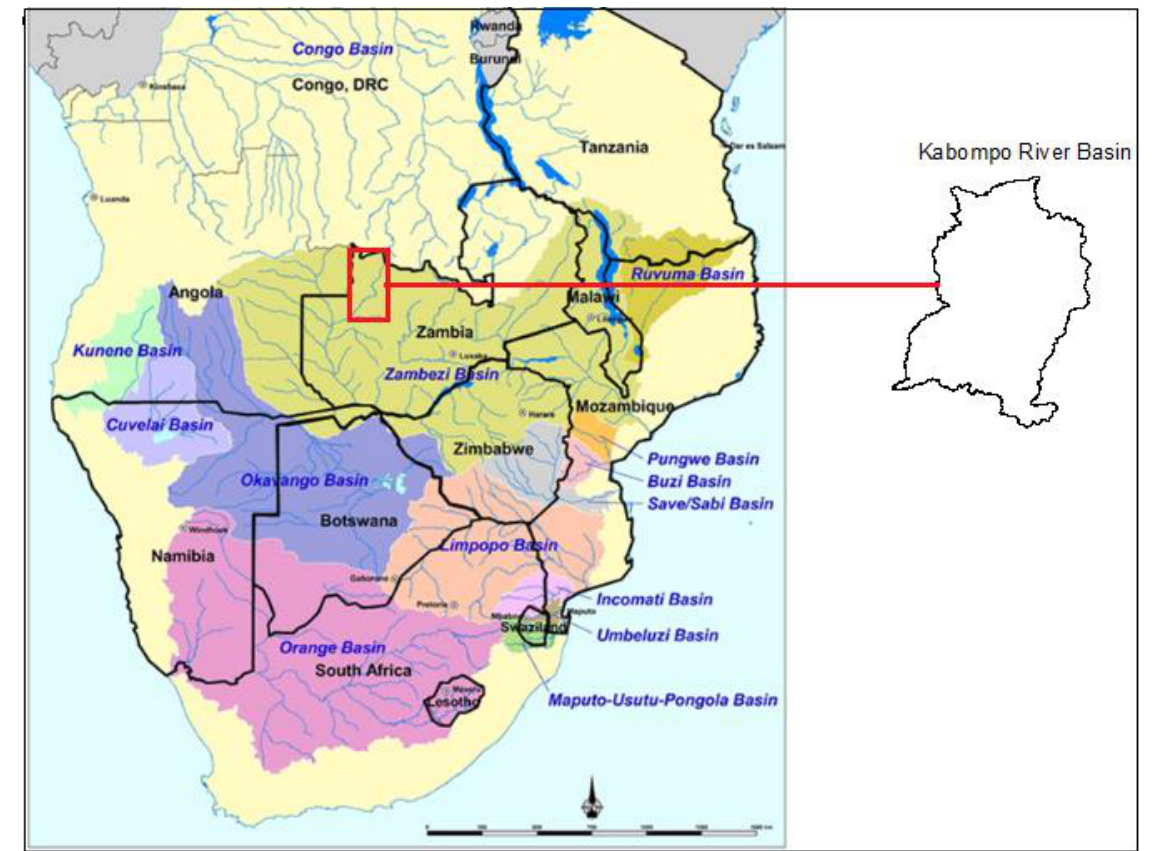
Figure 1. Location of study area (http://cridf.net/RC/wp-content/uploads/2018/01/CRIDF-Map-Project-distibution-1.jpg (accessed on 21 September 2021)).